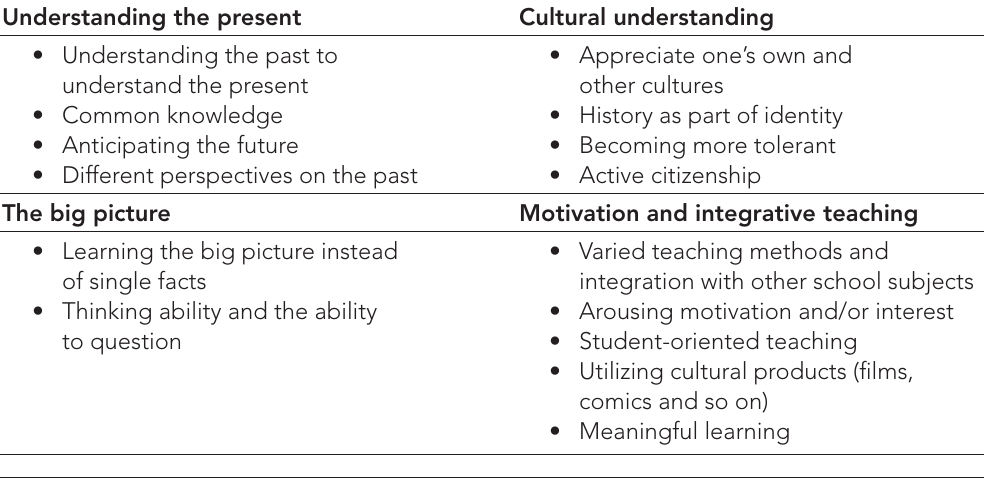
Table 2: Expressions categorized under the larger themes